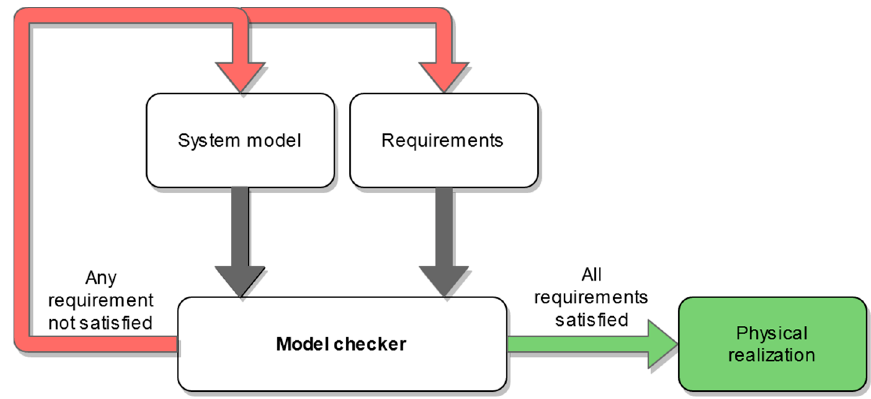
Figure 5. Process of symbolic model checking.